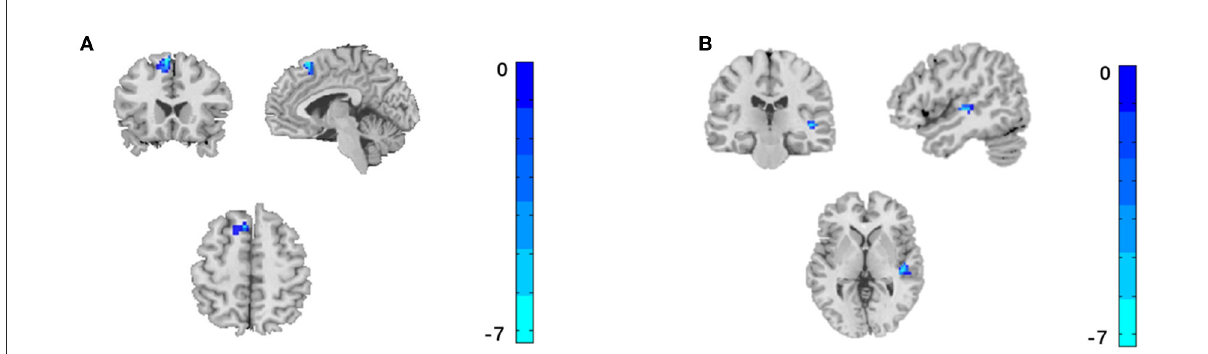
FIGURE4 Significant difference for FC between post-acupuncture in subjective tinnitus and healthy control. The result was corrected for GRF with voxel p < 0.001, cluster p < 0.05. (A) FC between AMYG and left superior frontal gyrus. (B) FC between AMYG and right superior temporal gyrus.